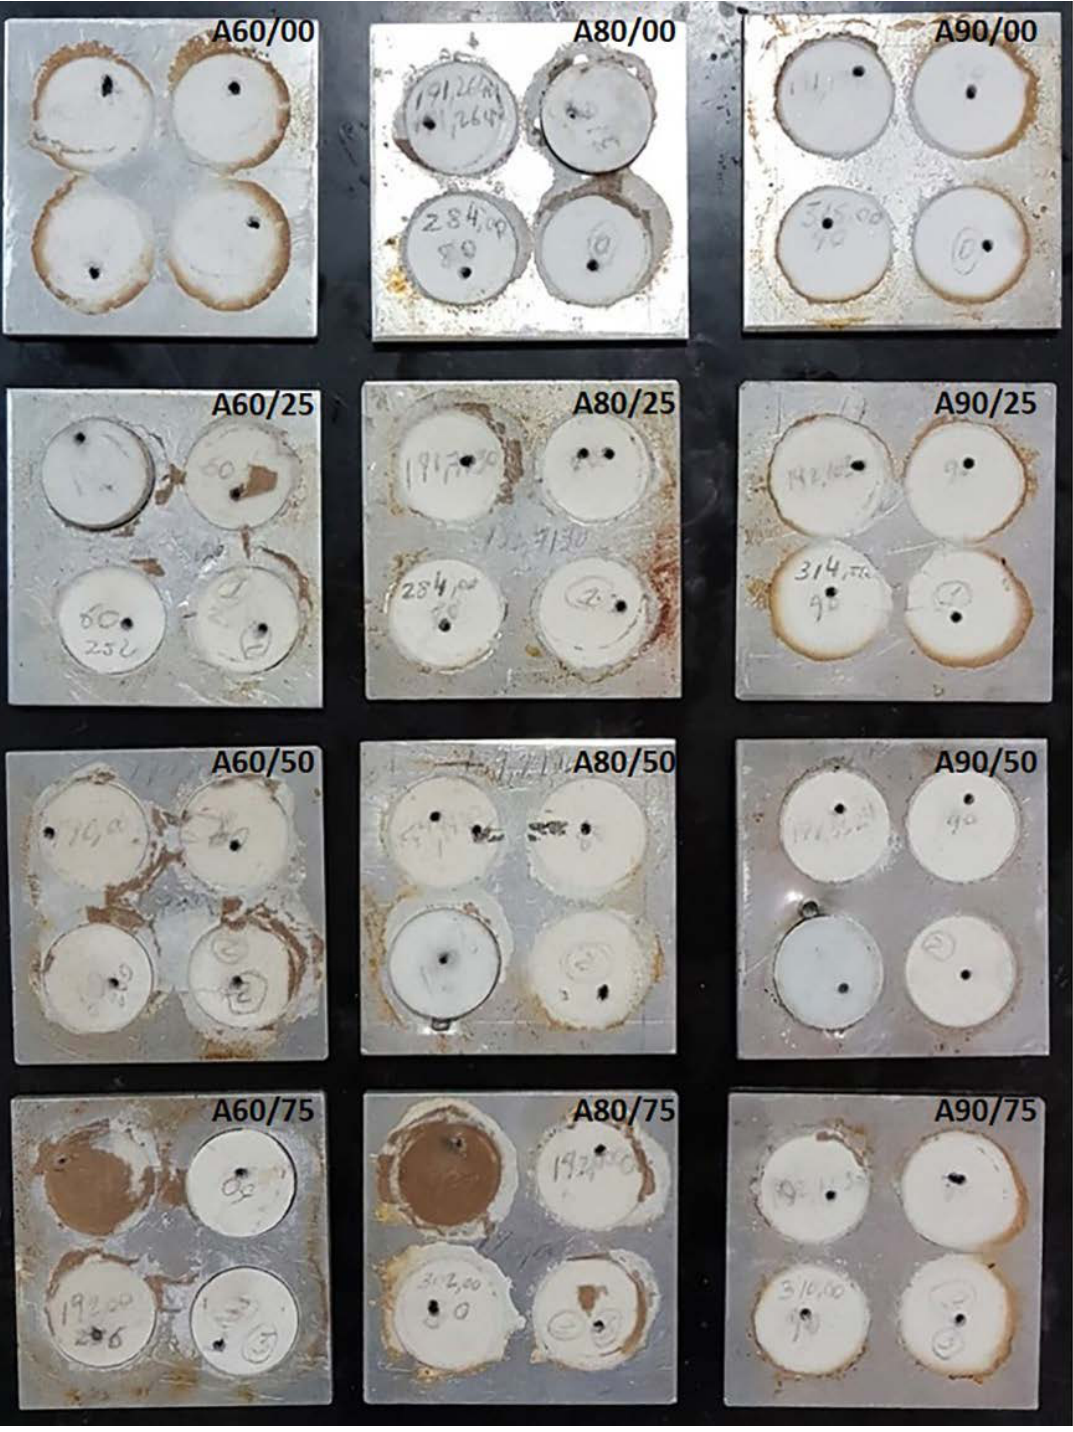
Figure 1. A60/00, A60/25, A60/50, A60/75, A80/00, A80/25, A80/50, A80/75, A90/00, A90/25, A90/50 and A90/75 samples after the first shot, arranged in top-down